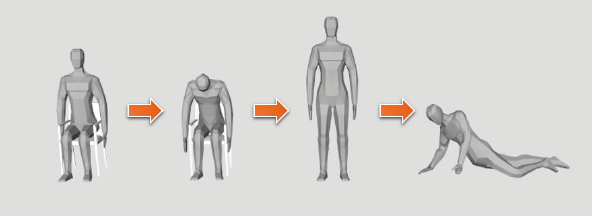
Figure 10: An example of posture transition